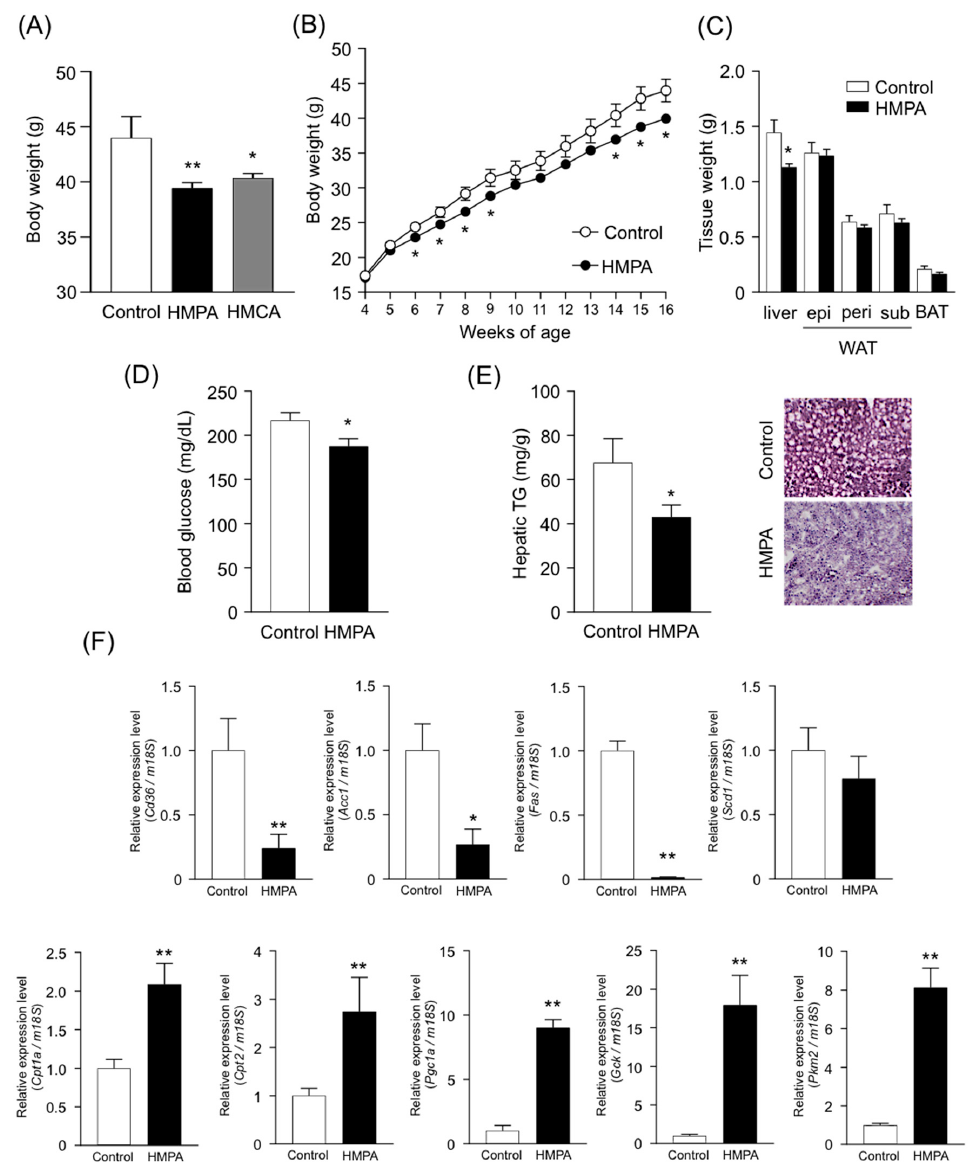
Figure 3. Metabolic parameters and histological changes in HMPA-supplemented HFD-fed mice. ( A ) Body weights after feeding control diet, HFD containing HMCA, and HFD containing HMPA for 12 weeks. ( B – E ) Metabolic parameters and histological changes in HFD controls and HMPA-supplemented HFD-fed mice. Mice were characterized for body weight gain ( B ), the mass of WAT, BAT, and liver ( C ), blood glucose ( D ), and hepatic TG and histology of hepatocytes by H&E staining ( E ) ( n = 7–9). ( F ) Relative mRNA expressions involved in energy expenditure ( Pgc1a ), β -oxidation ( Cpt1a and Cpt2 ), fatty acid synthesis ( Fas , Acc1 , and Scd1 ), fatty acid trafficking ( Cd36 ), and glycolysis ( Gck and Pkm2 ) in the liver of HFD controls and HMPA-supplemented HFD-fed mice ( n = 7). Results are expressed as fold mRNA change vs. HFD control; values were set to 1. To compare mRNA expression levels among samples, copy numbers of all transcripts were normalized to 18S mRNA expression levels, an internal control. All data are presented as the means ± SEM. Differences were assessed using one-way ANOVA followed by Dunnett's multiple comparison test ( A ) and by Student’s t -test (B–F). Significance is established at adjusted ** p <0.01, and * p <0.05. Control, HFD containing with 1% cellulose fed mice. HFD: high-fat diet; HMCA: 4-hydroxy-3-methoxycinnamic acid; HMPA: 3-(4-hydroxy-3-methoxyphenyl)propionic acid.